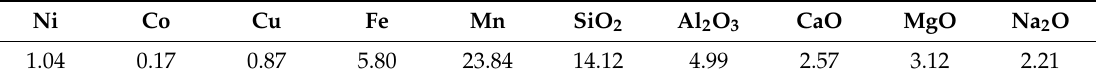
Table 3. Main chemical composition of ocean polymetallic nodules / wt.